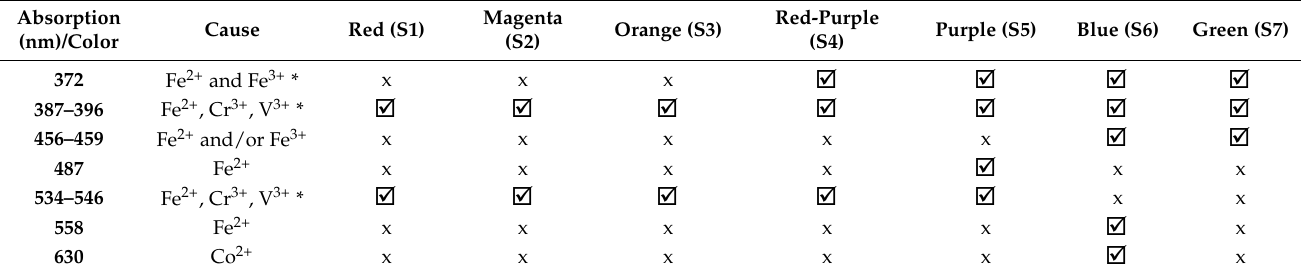
Table 4. Summary of UV-visible absorption approximate in each colored spinel groups. Absorption (nm)/Color